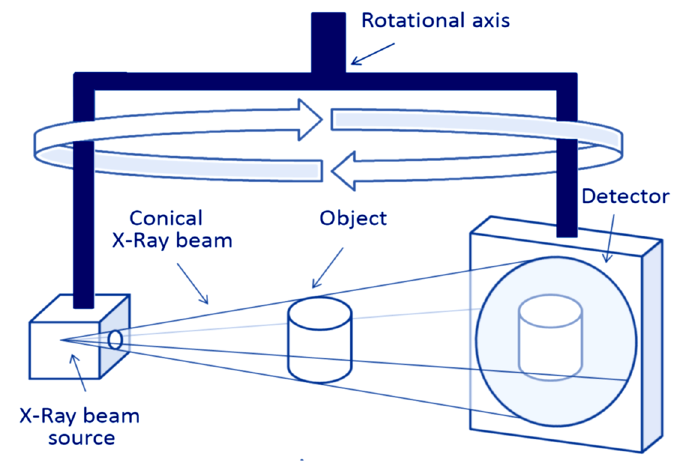
Figure 13. Diagram of a conebeam computed tomography (CBCT) scanner.